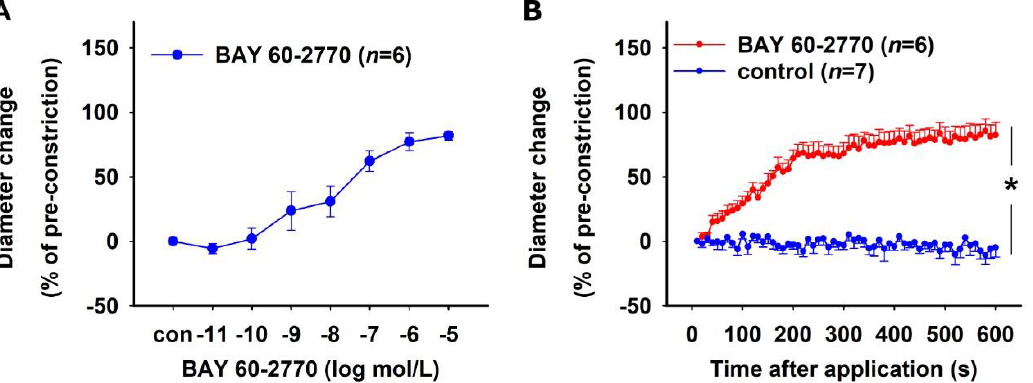
Figure 3. Effect of the soluble guanylyl cyclase activator—BAY 60-2770. Rat DVR were pre-treated with 10 − 4 mol/L L-NAME and pre-constricted with 10 − 6 mol/L Ang II. ( A ) Concentration–response curve showing relaxation induced by 10 − 11 –10 − 5 mol/L BAY 60-2770. Vessel diameter did not change in the absence of BAY 60-2770 (con). ( B ) Time–response curves showing relaxation induced by 10 −6 mol/L BAY 60-2770 over a period of 10 min. Control vessels without BAY 60-2770 treatment remained constricted throughout the experiment (Brunner test, * p < 0.001).